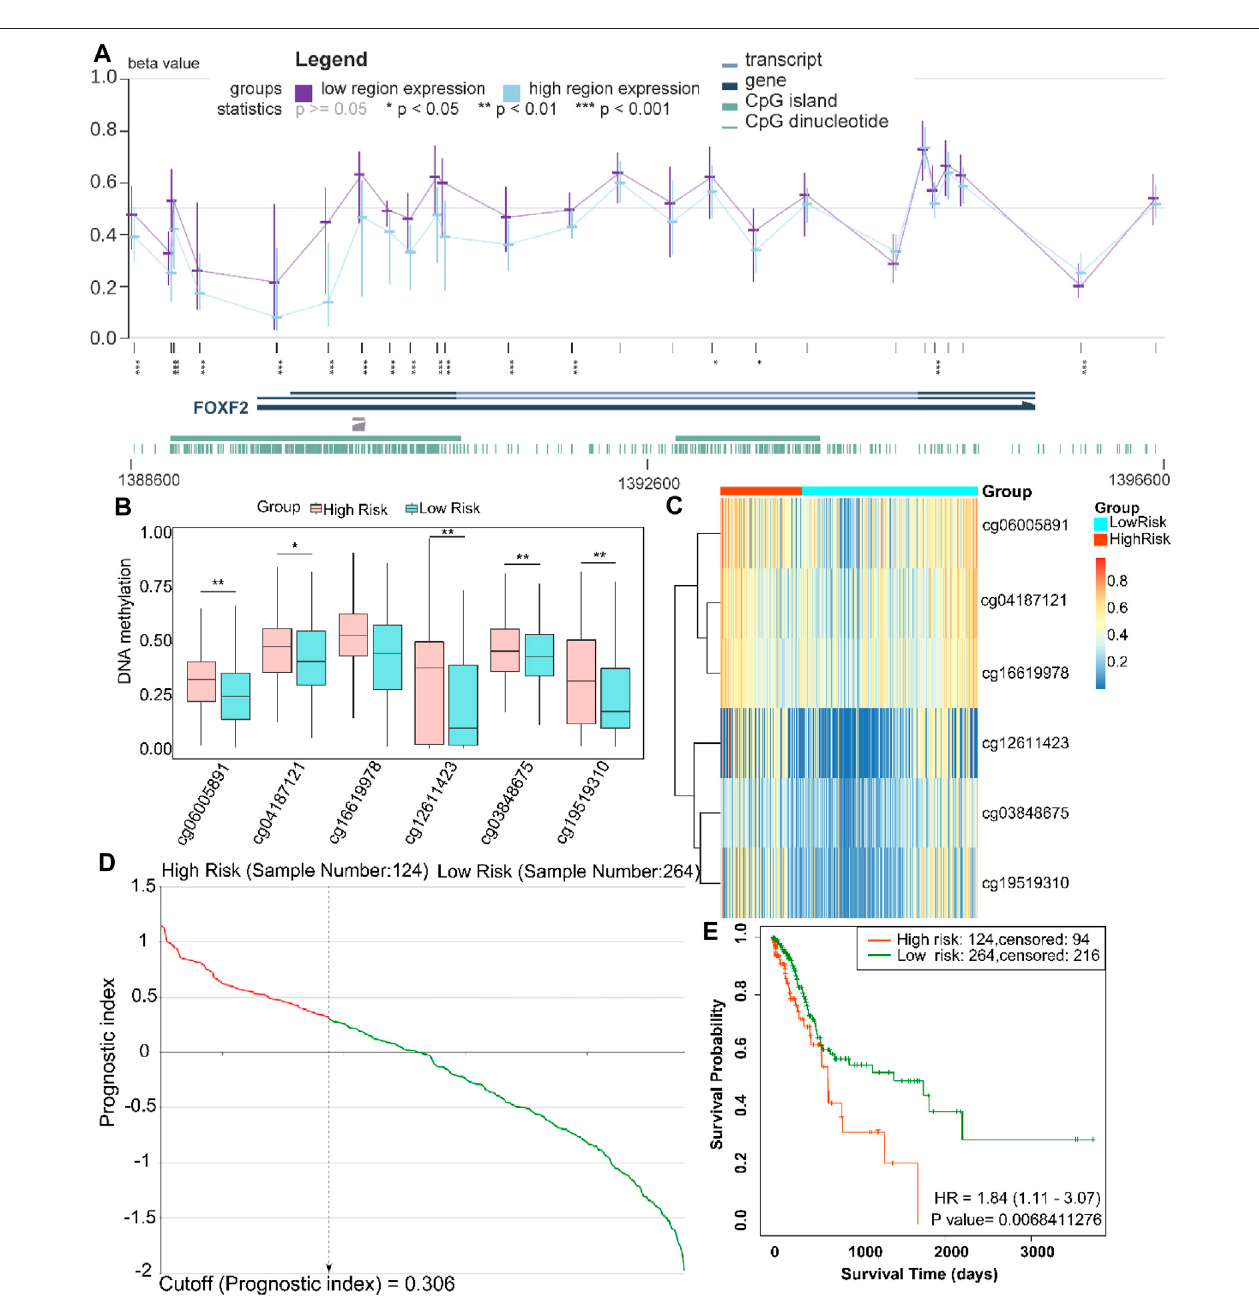
FIGURE 4 | FOXF2 is a prognostic index for patients with GC patients. (A) The methylation levels of most of the cg loci in the low FOXF2 expression group were signi fi cantly higher than those in the high FOXF2 expression group as determined from MEXPRESS. (B,C) SurvivalMeth data showed that the methylation levels of 5 promoter region cg loci (cg06005891, cg04187121, cg12611423, cg03848675, and cg19519310) in the high risk group were signi fi cantly higher than those in the low risk group. The methylation level of cg16619978 in the high risk group was also higher than that in the low risk group; however, the difference was not signi fi cant. (D) At the optimal cutoff prognostic index of 0.306, a total of 388 GC samples were divided into high or low risk group. (E) The Kaplan-Meier analysis showed that patients in the high risk group had a poorer survival probability than those in the low risk group (HR (cid:1) 1.84 (1.11 – 3.07)